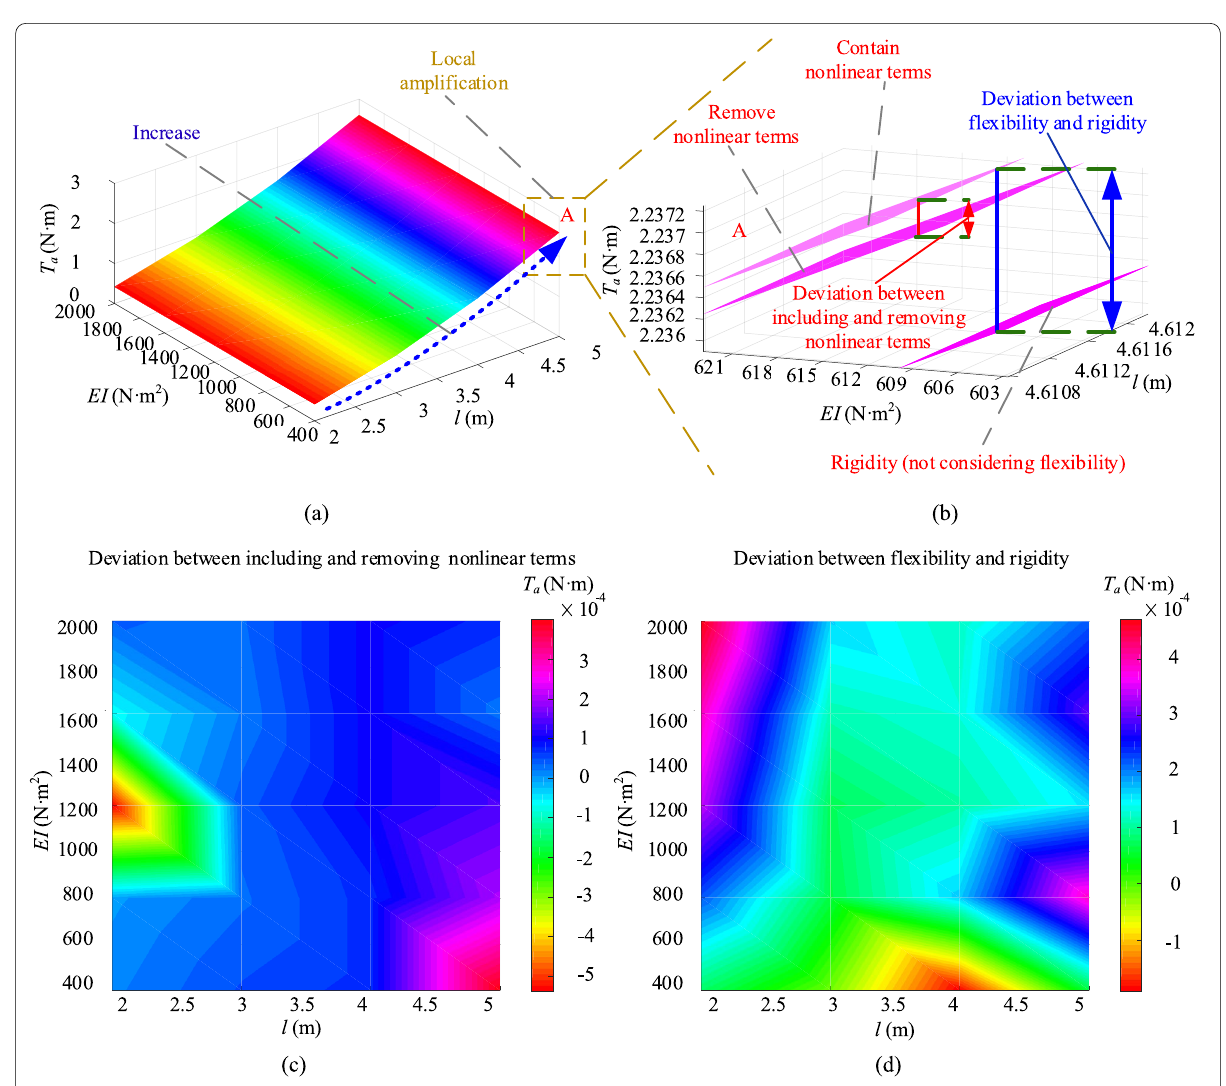
Figure 5 Input torque of flexible manipulators at low speed: ( a ) Relationship between input torque, length, and flexural rigidity, ( b ) Partial enlarged view of ( a ), ( c ) Influence of nonlinear terms on input torque, ( d ) Influence of flexibility on input